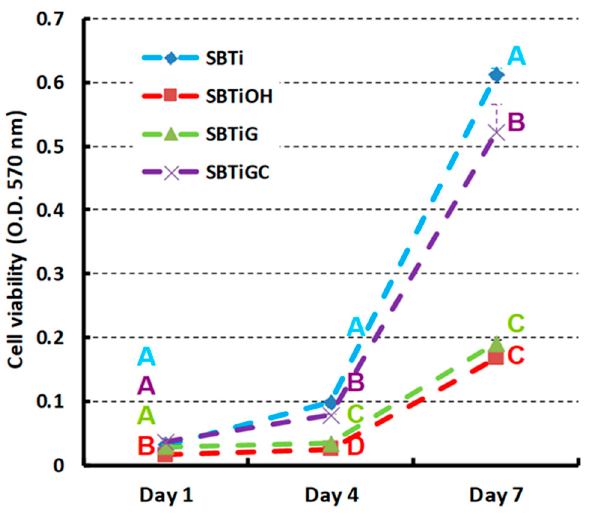
Figure 5. Proliferation of hMSCs on test samples following cell incubation for 7 d (groups with different letters are significantly different ( p < 0.05)).